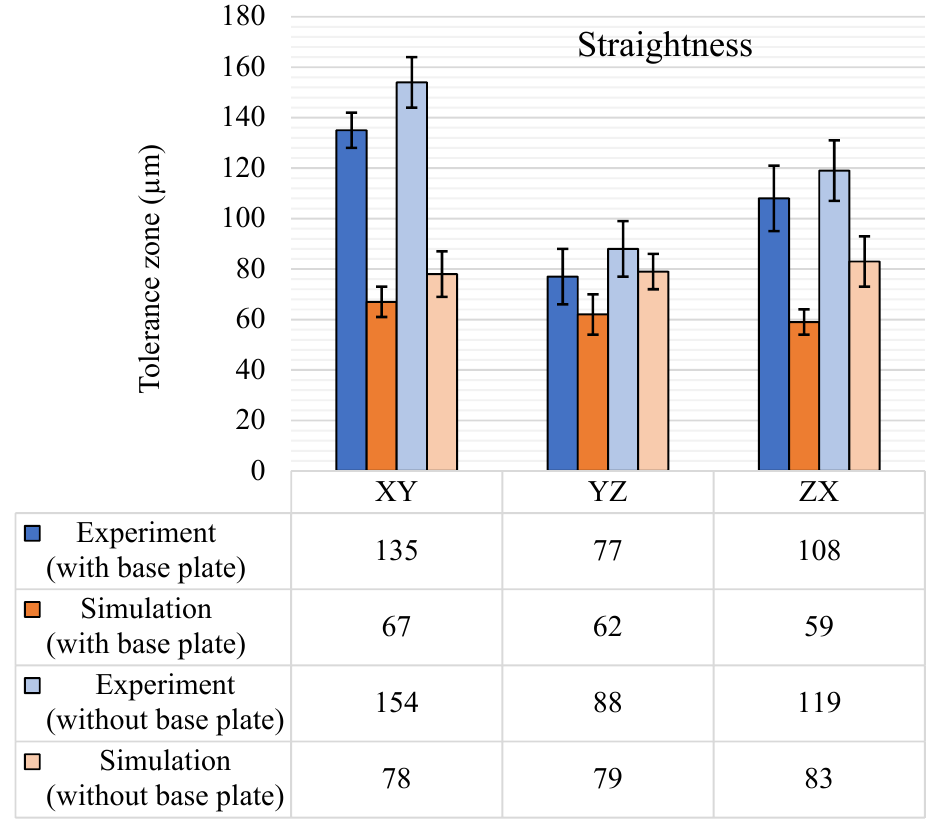
Figure 7. Straightness tolerance results (µm), with and without the base plate.